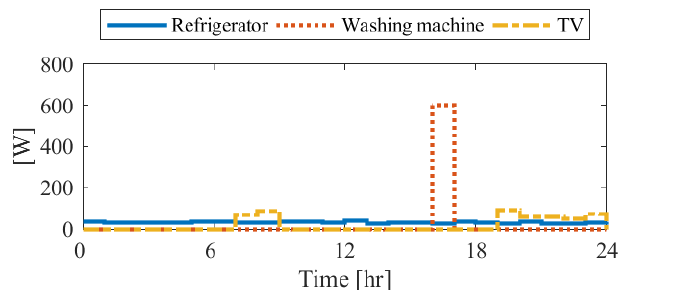
Figure 3. Home appliances power consumption